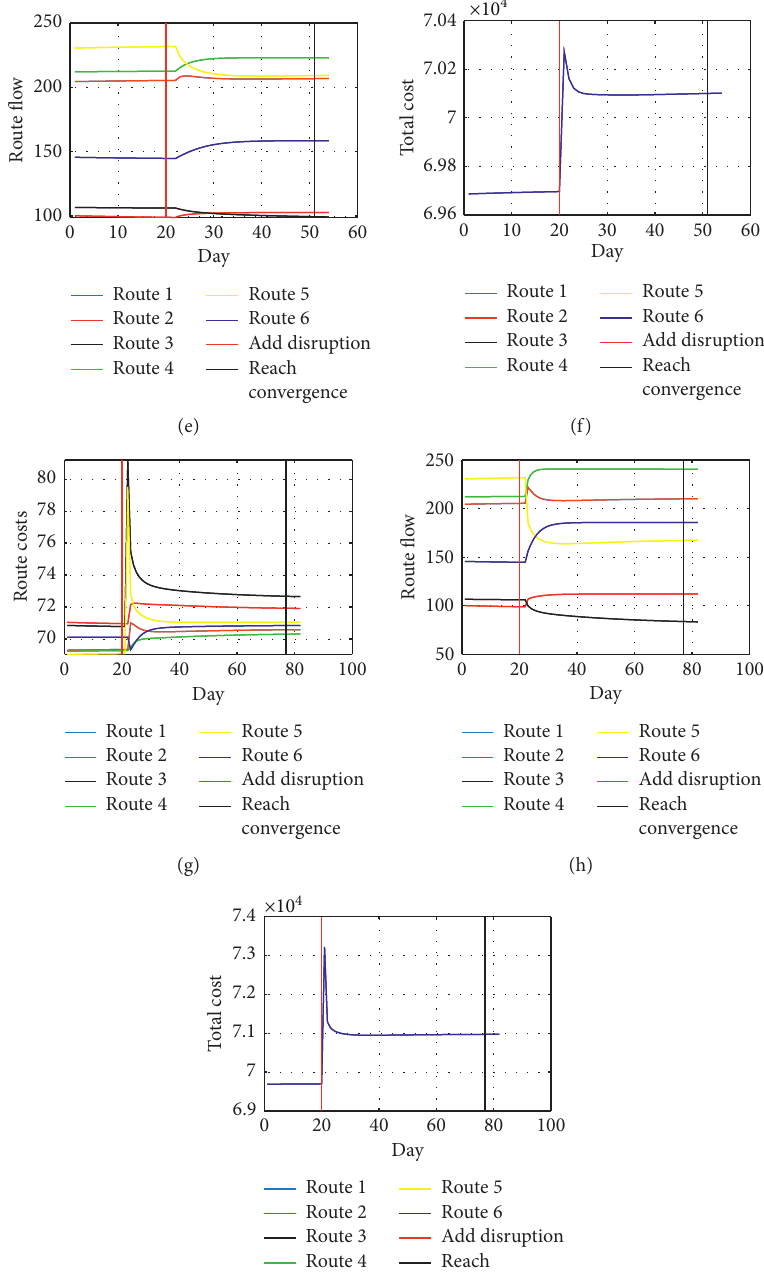
Figure 6: Evolution of route costs, route flow, and total cost evolution under different levels of disruptions when the ASC based on DRL is employed. First row (from (a) to (c)): the evolution of route costs, route flow, and total cost when the capacity of link 9 reduces by 25%; second row (from (d) to (f)): the evolution of route costs, route flow, and total cost when the capacity of link 9 reduces by 50%; third row (from (g) to (i)): the evolution of route costs, route flow, and total cost when the capacity of link 9 reduces by